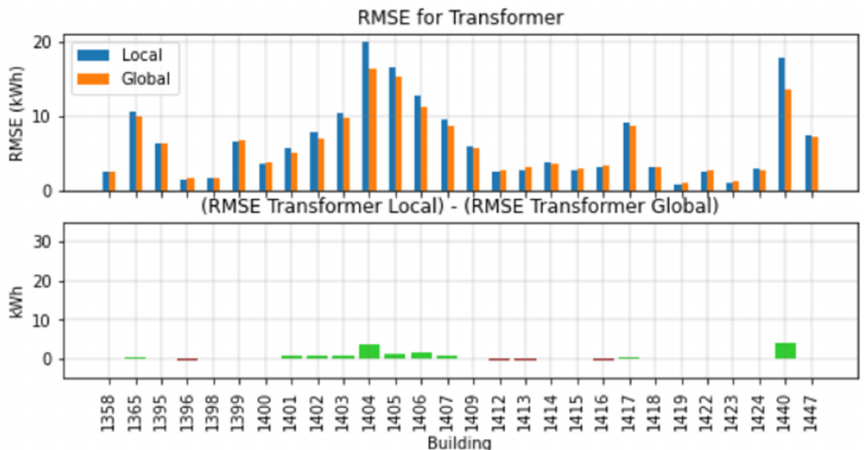
Figure 14. Comparison (in the upper figure) and difference (in the lower figure) between the RMSE obtained from local and global Transformer models on test